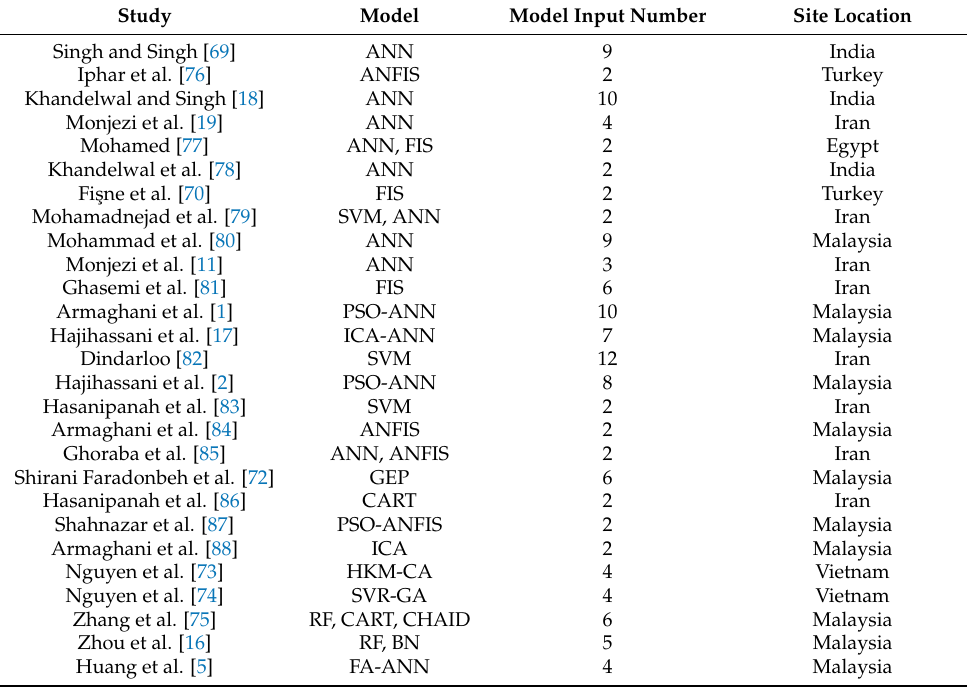
Table 1. The most prominent research on the PPV prediction by means of the SC